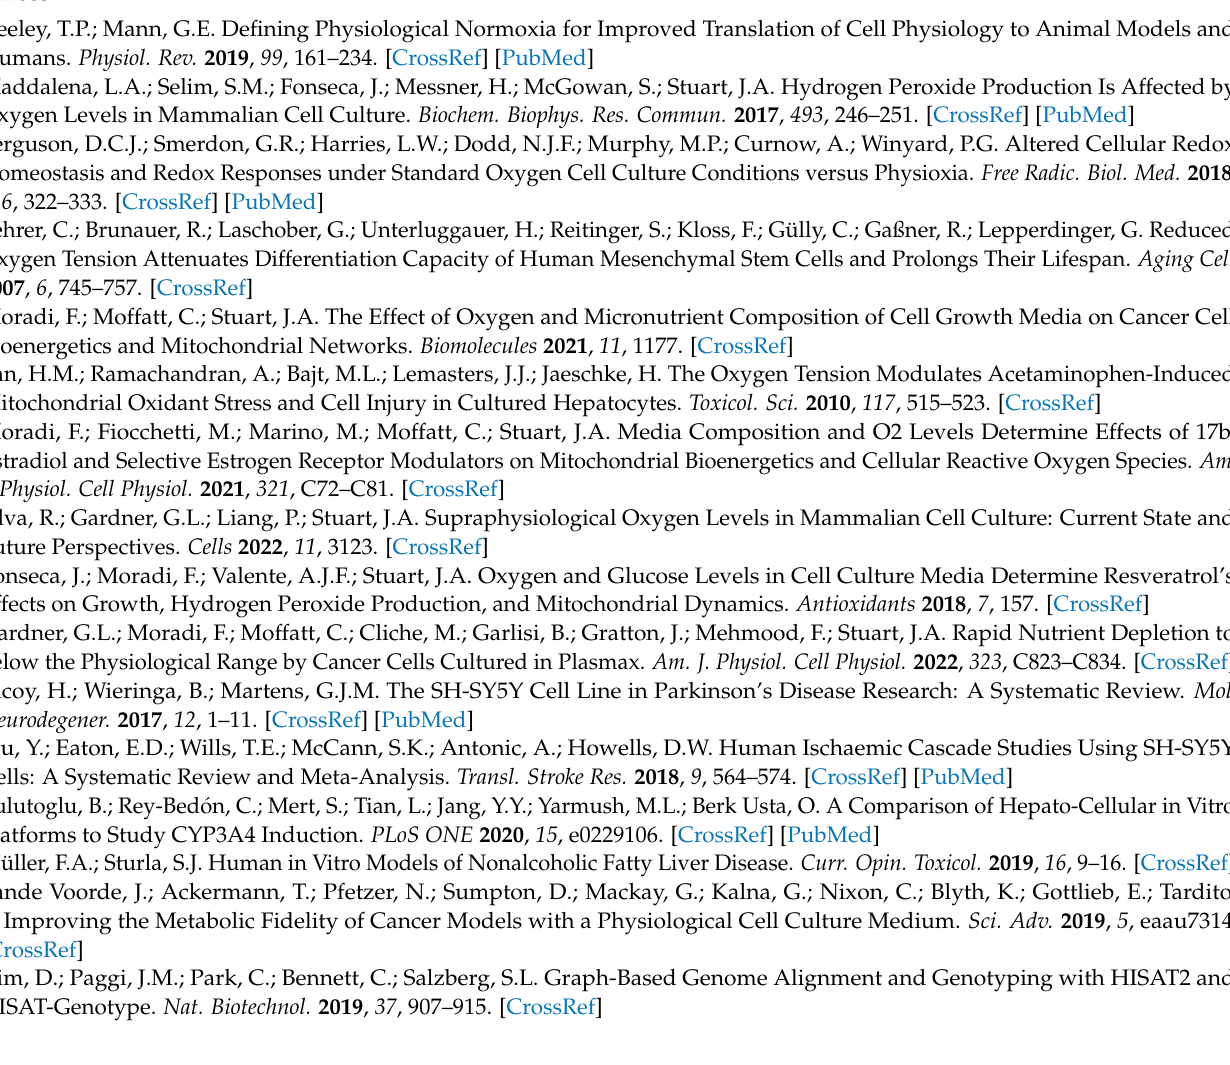
Functional Enrichment HIF targets in Huh-7.xlsx. Table S17: Functional Enrichment HIF targets in PC-3.xlsx. Table S18: Functional Enrichment HIF targets in